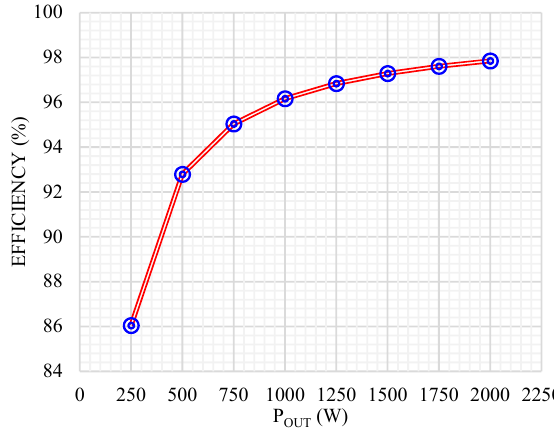
Figure 4. Inverter efficiency at different power output.